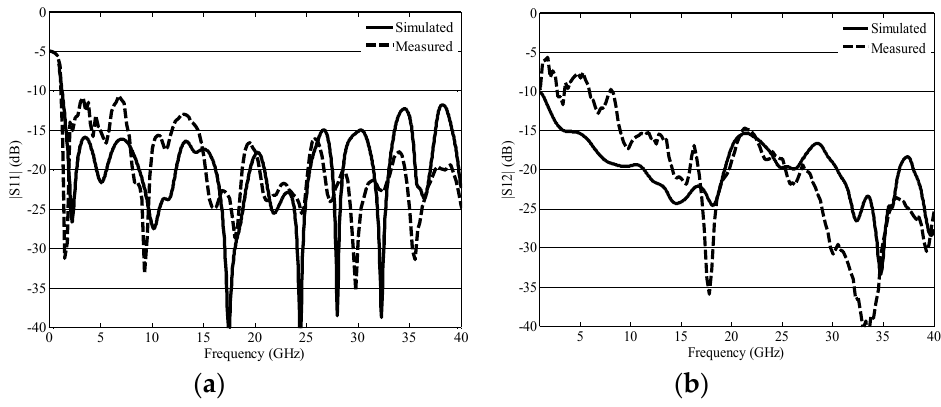
Figure 5. The schematic diagram ( a ) ( left side ) fabricated ( right side ) without t-shape corrugated strip and ( b ) ( left side ) fabricated ( right side ) with t-shape corrugated strip of the MIMO antenna. Figure 6. The simulated and measured s-parameters ( a ) s11 and ( b ) s12.